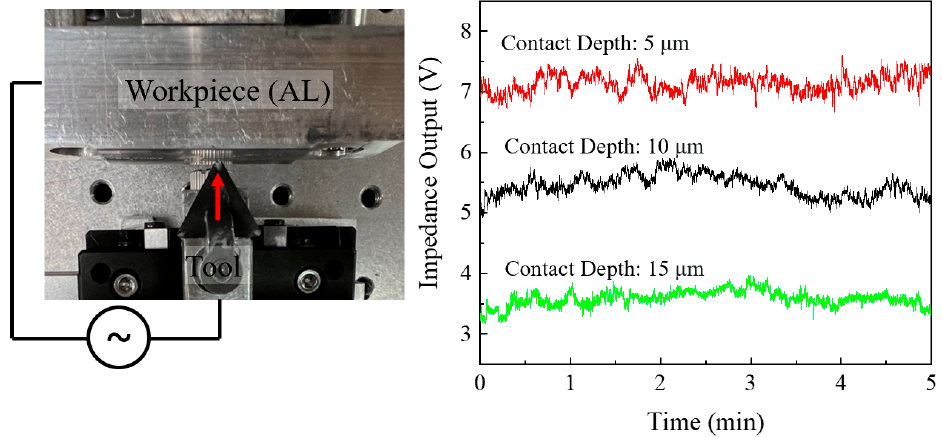
Figure 6. Experiment setup for stability test and results.